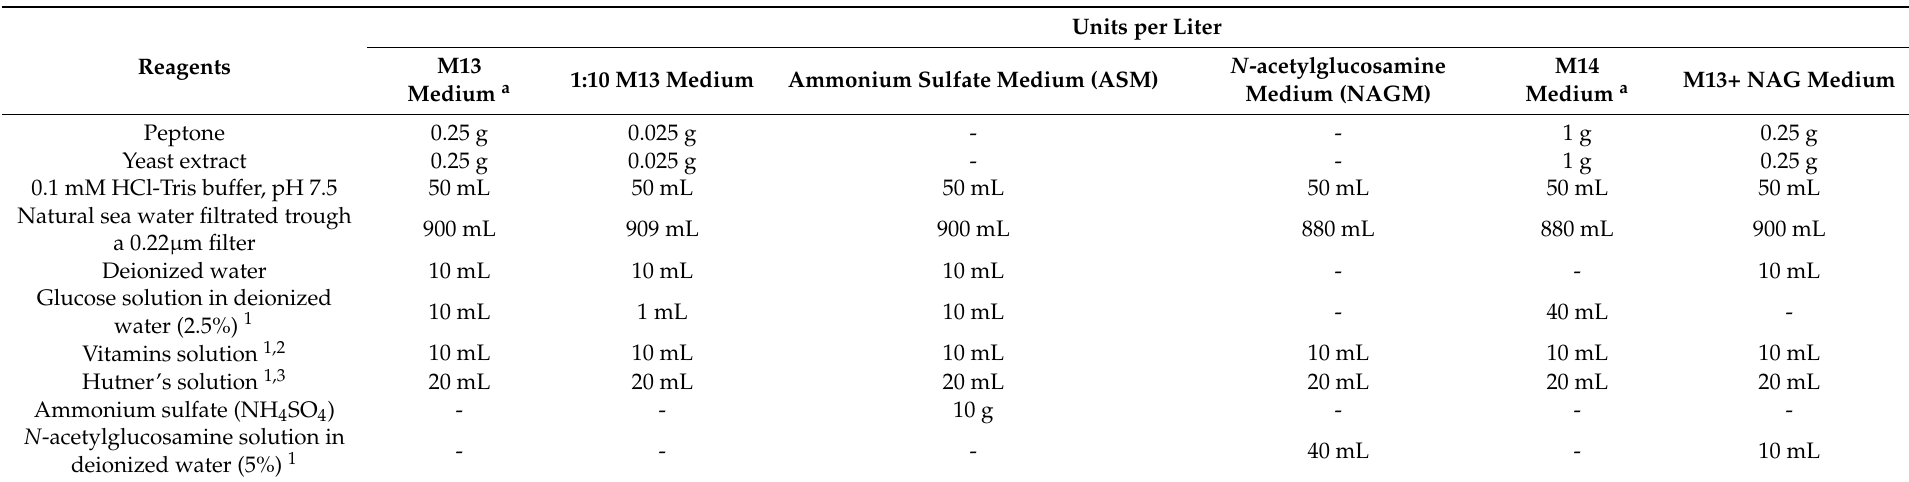
Table 2. Composition of the culture media